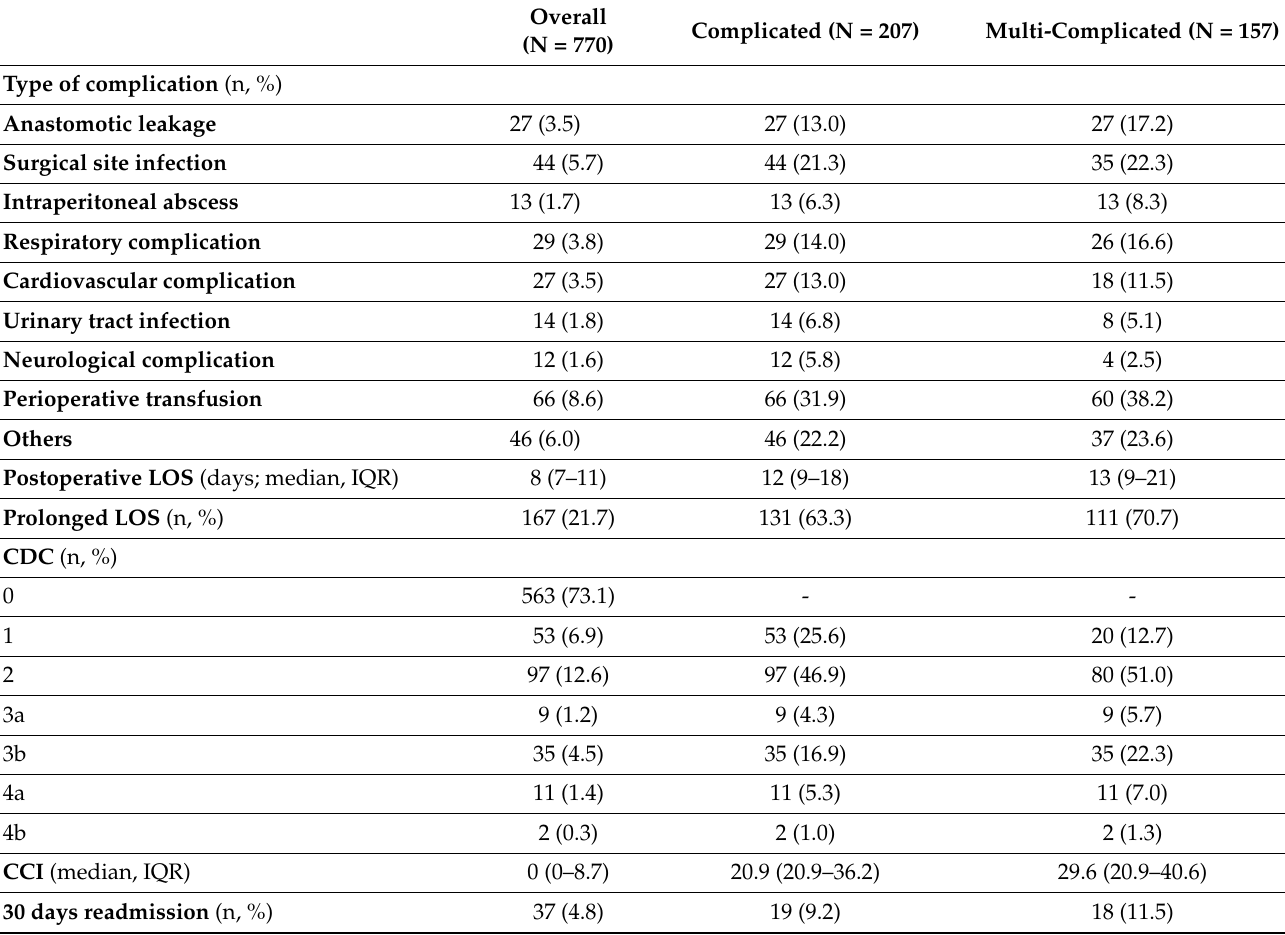
Table 2. Outcomes of the study